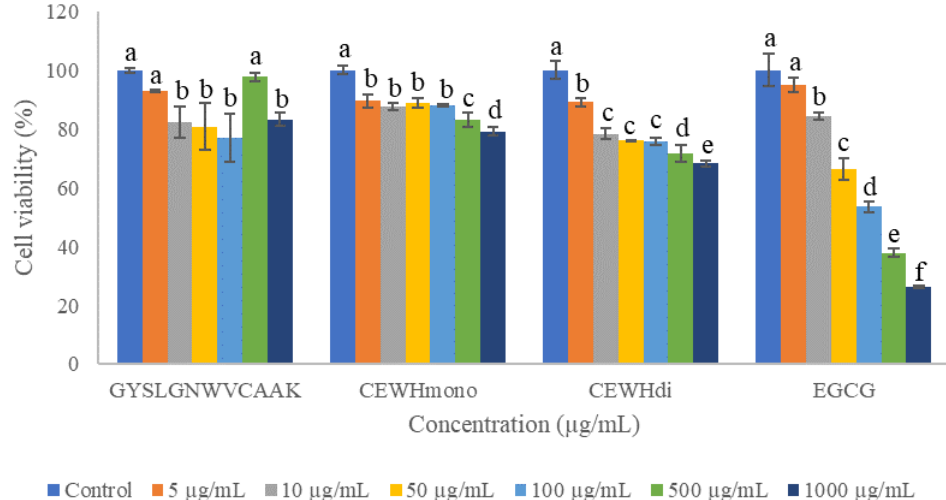
Figure 2. Effects of various concentrations of GYSLGNWVCAAK, CEWH mono , CEWH di and EGCG on the cell viability of B16F10 melanoma cells. Note: Results were reported as the mean ± standard deviation ( n = 3); different lowercase letters above the bars indicate significant difference at p < 0.05 according to Duncan’s test.